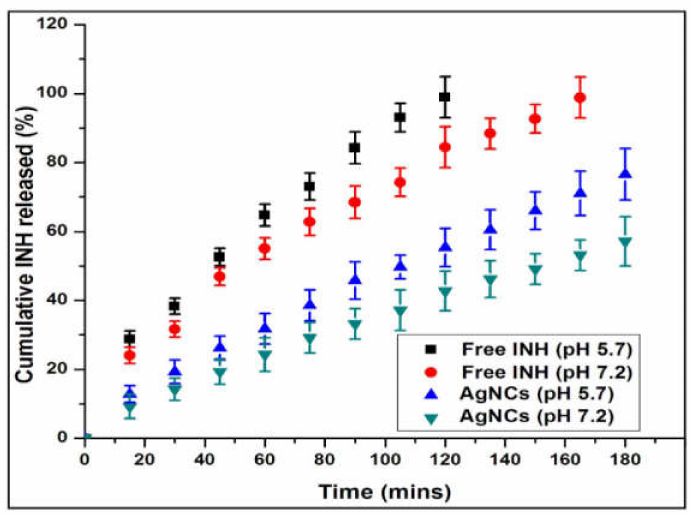
Figure 6. In vitro release of INH from garlic-mediated synthesized AgNCs at 37 ◦ C either at pH 5.7 or pH 7.2. Free INH in 1X PBS was used as